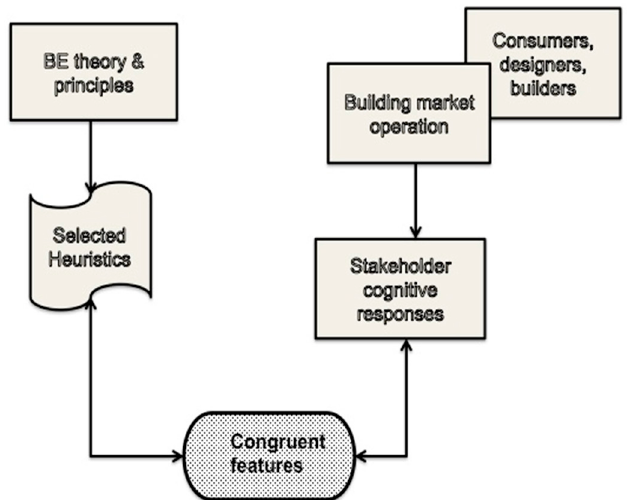
Figure 1. Approach to examining the impacts of behavioral heuristics on the cognitive processes employed by the building sector stakeholders, and the potential congruence between these features.